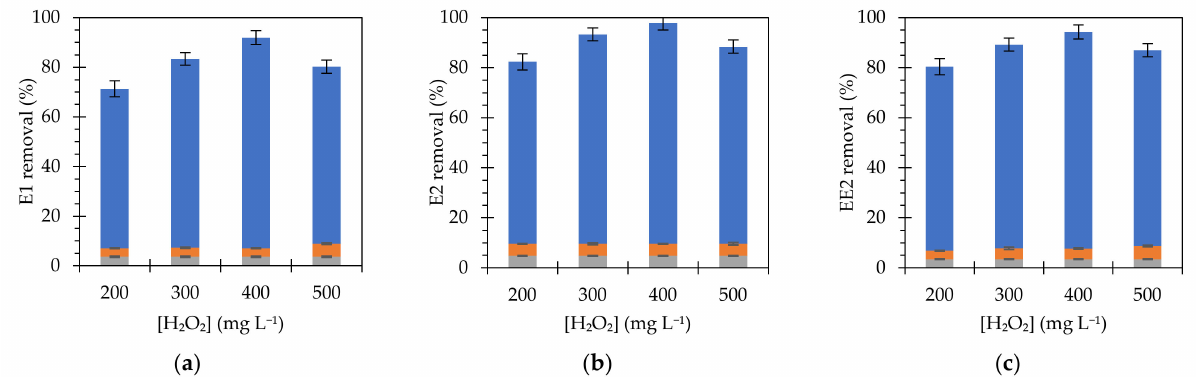
Figure 5. Effect of H 2 O 2 concentration on the removal of ( a ) E1, ( b ) E2 and ( c ) EE2 (initial concentration of 350 µ g L − 1 ), using Fe 3 O 4 @PAA/SBA15 with [Fe] at 750 mg L − 1 after 6 h. Blue bars represent estrogen removal by Fenton reactions; grey bars represent estrogen removal by adsorption; orange bars represent H 2 O 2 controls.